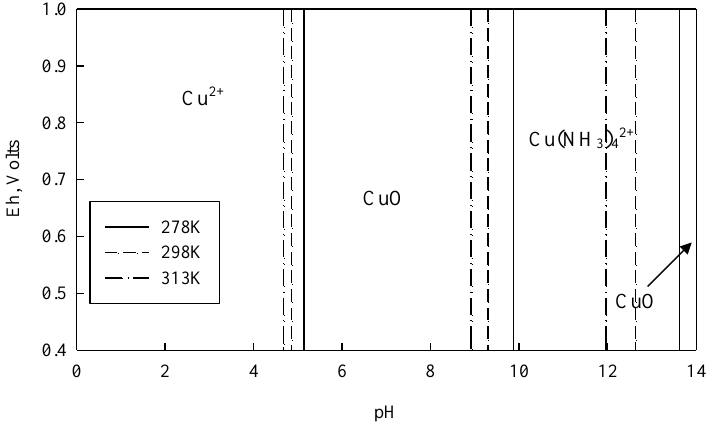
Figure 5. Diagram of Cu-NH 3 -H 2 O medium stability at a copper concentration of 0.0043 mol / dm 3 and ammonia concentration of 0.1 mol / dm 3 . The solid line corresponds to the equilibrium arising at 278 K, the dotted line is equilibrium at 298 K and the dashed line is equilibrium at 313 K.